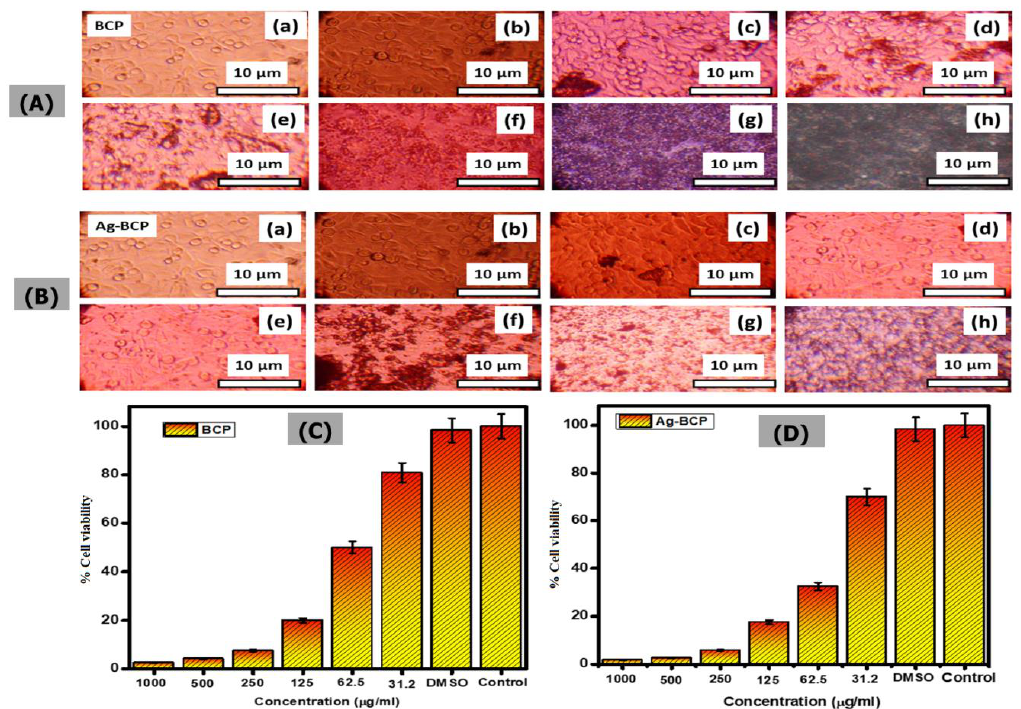
Figure 14. Optical microscopic images of L929 fibroblast cells under various concentrations of BCP 460